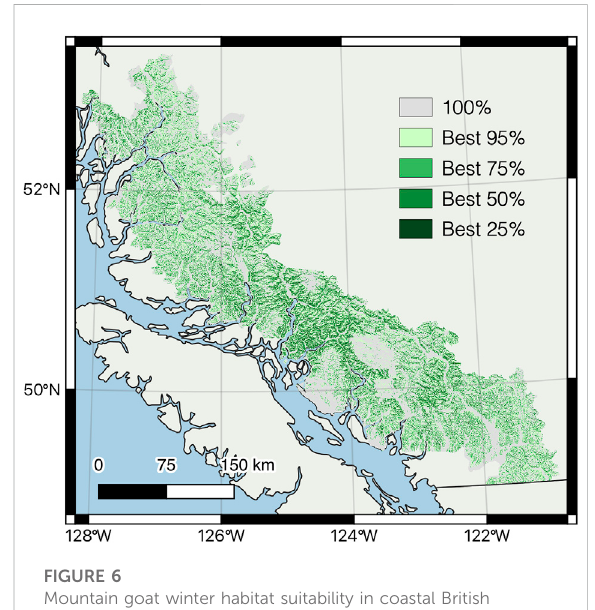
FIGURE 6 Mountain goat winter habitat suitability in coastal British Columbia, Canada, basedontheprobabilityofselectionestimated by the Bayesian network analysis of observations versus random locations. Modelled habitat suitability for each observation wasrankedfromhighesttolowestandclassesre fl ectthesuitability of habitat in which different proportions of observations were located (e.g., the 25% of telemetry locations with the highest habitat suitability we ’ re located in areas modelled in the darkest